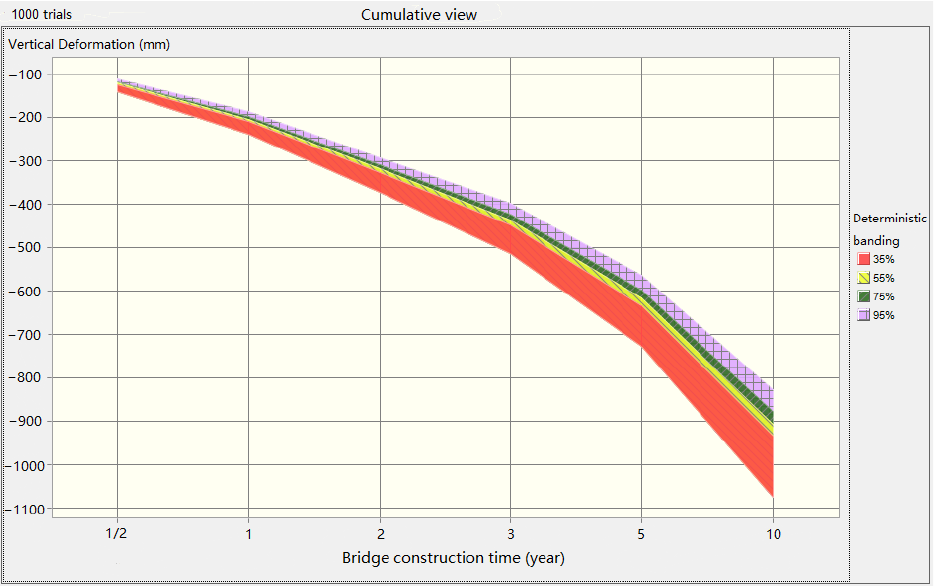
Figure 8. Vertical deformation predicted interval at different confidence levels.